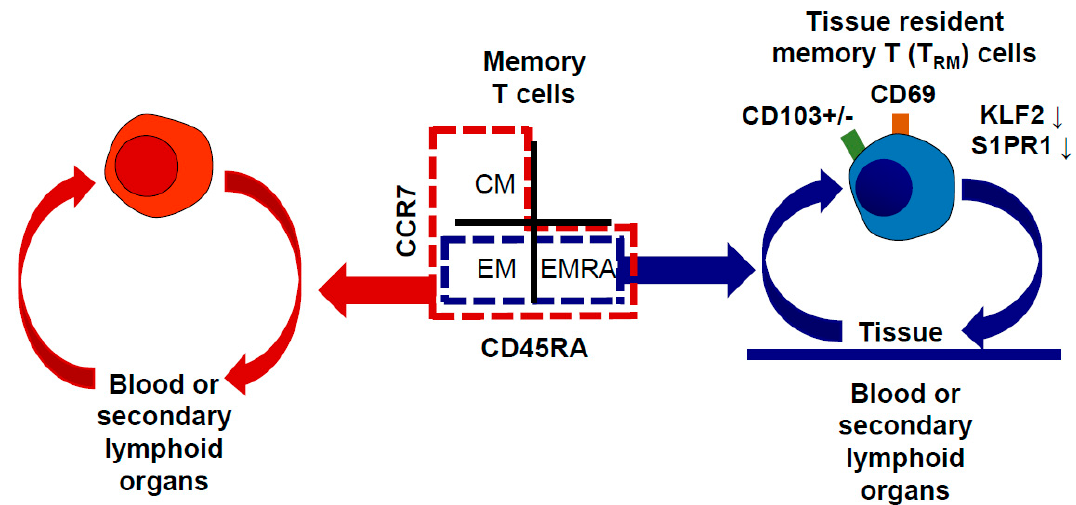
Figure 1. Characteristics of tissue-resident memory T (T RM ) cells. T RM cells express CD69 and CD103, though CD103 expression is variable depending on the type of peripheral organ. These cells also downregulate KLF2 and S1PR1 and cannot egress to the blood or secondary lymphoid organs; therefore, they reside in the peripheral tissues. T RM cells do not express CCR7 and exhibit an effector memory T cell (T EM ) phenotype or effector memory T cells re-expressing CD45RA (T EMRA ) phenotype. However, circulating memory T cells also have central memory T (T CM ) cells that express CCR7 but not CD45RA. CM, central memory; EM, effector memory; EMRA, effector memory re-expressing CD45RA.